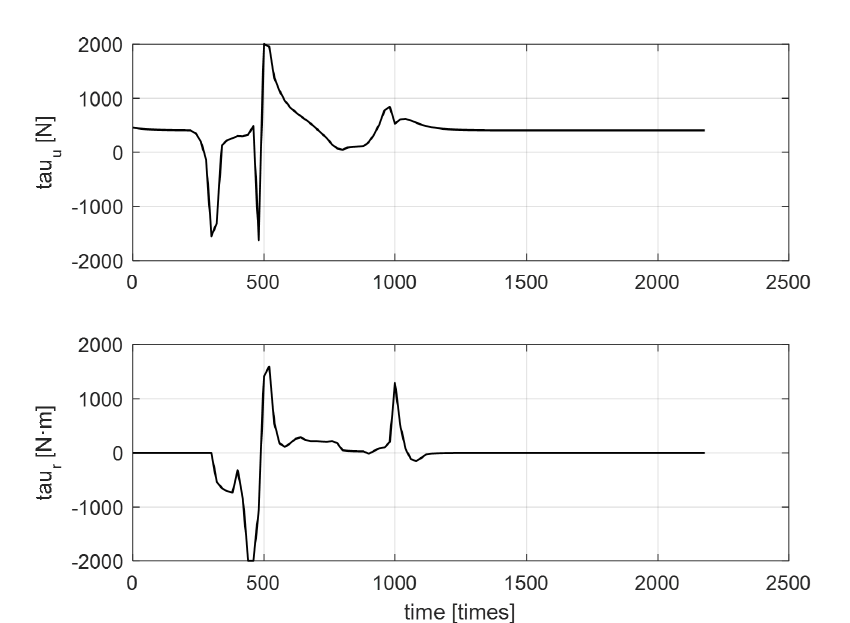
Figure 16. Variability of control in dynamic collision avoidance